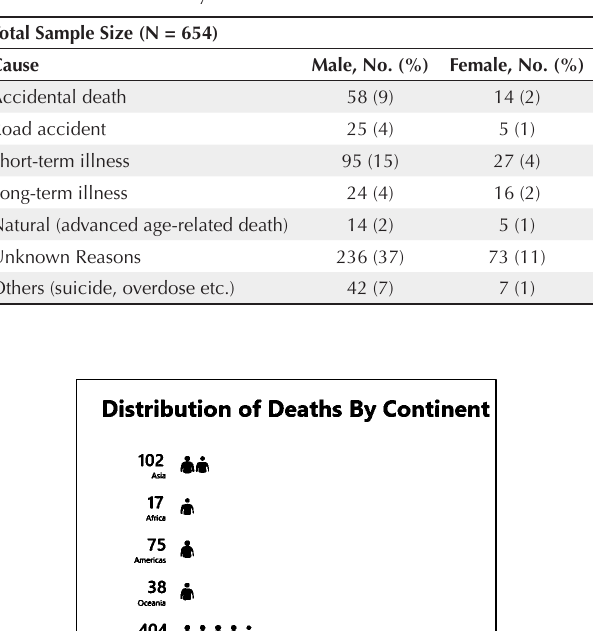
Table 1. Causes of Death by Gender